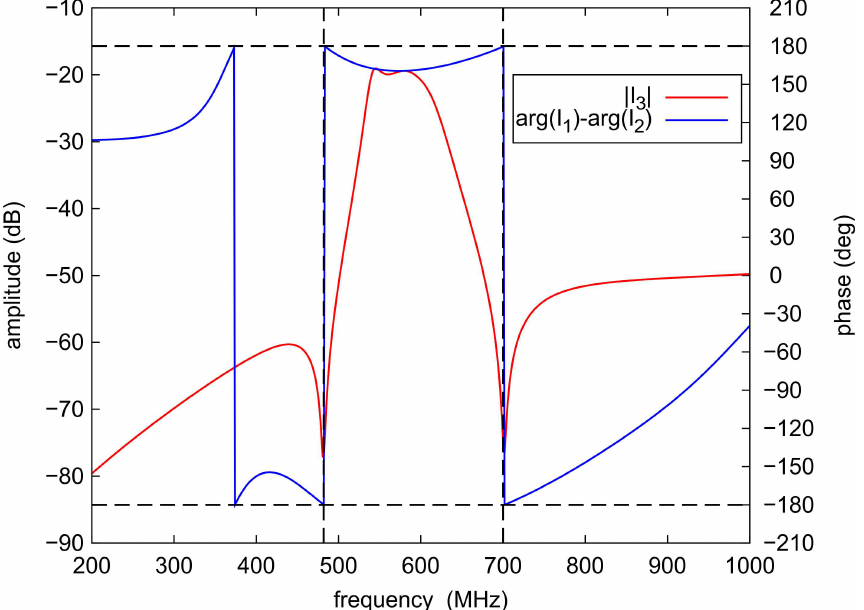
Figure 20. The I3 current amplitude and the phase difference of the I 1 and I 2 currents at the out- put